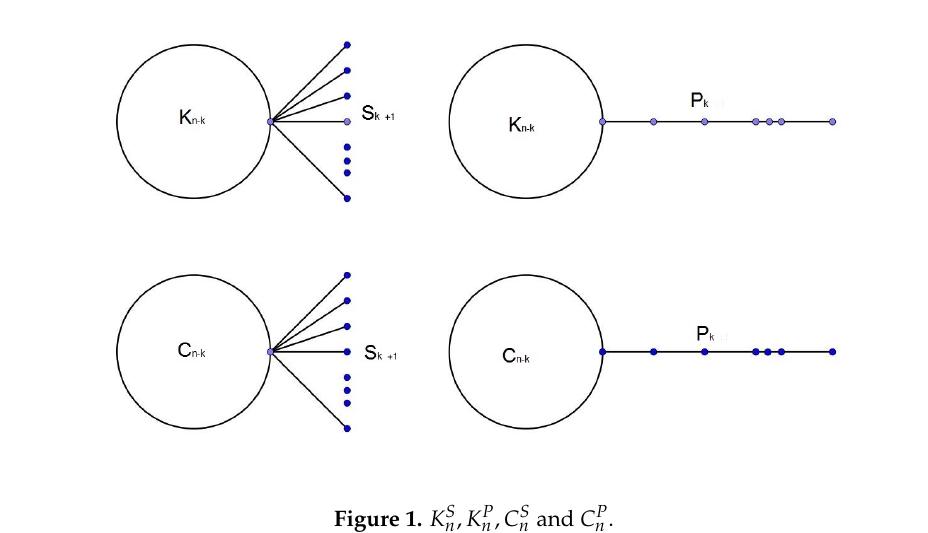
Figure 1. K S n , K P n , C S n and C P n